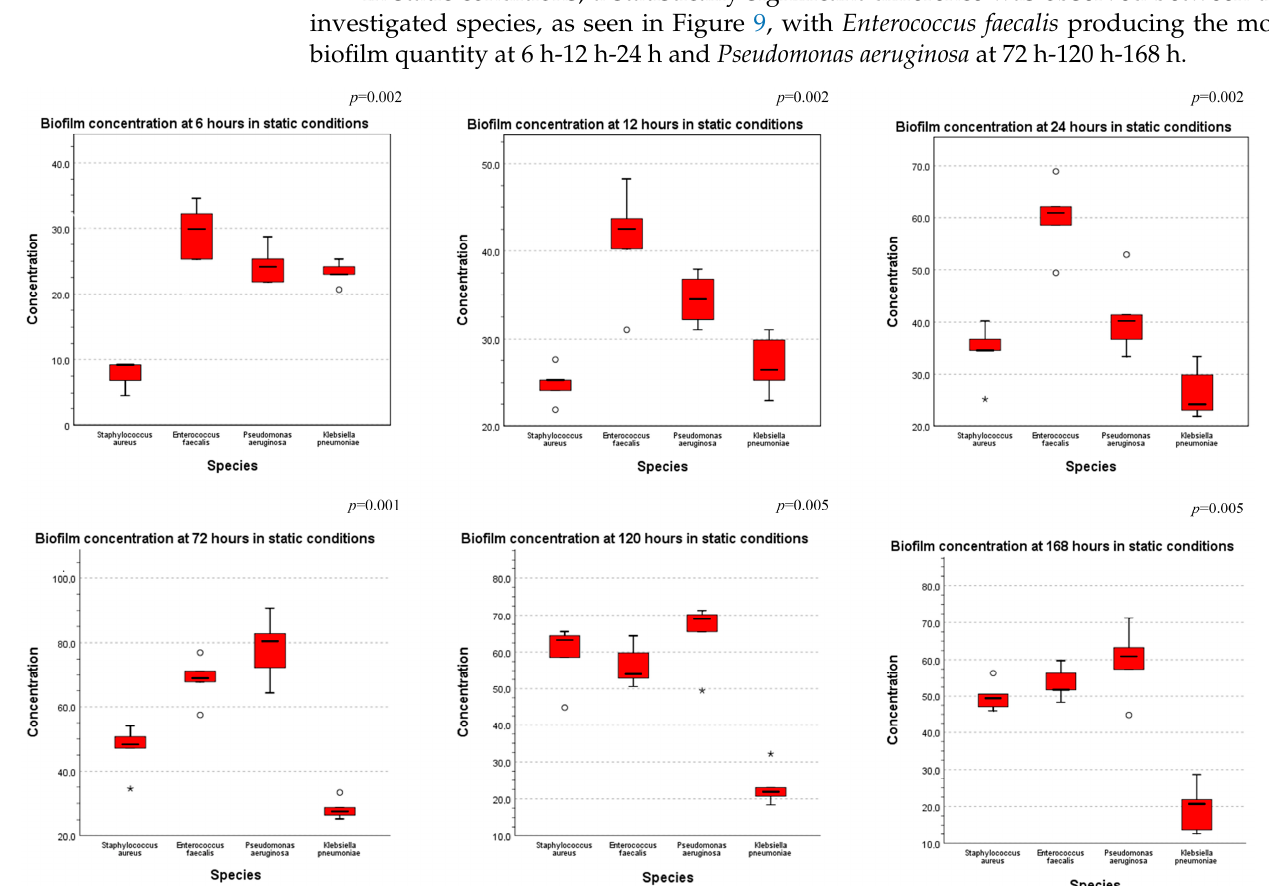
Figure 9. Comparison of biofilm concentration across all species tested in static conditions, at 6 h-12 h-24 h-72 h-120 h-168 h (ANOVA test performed— p -values